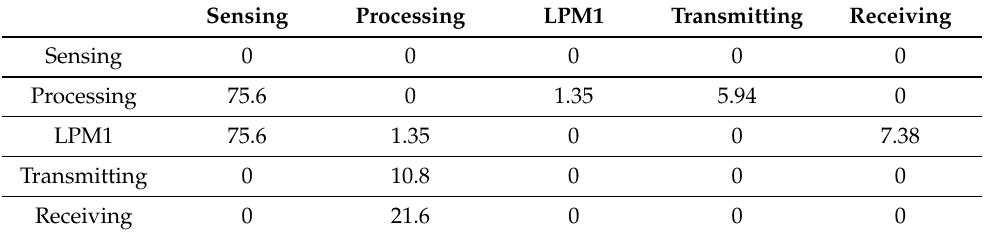
Table 6. Transitions’ energy consumption ( µ J).